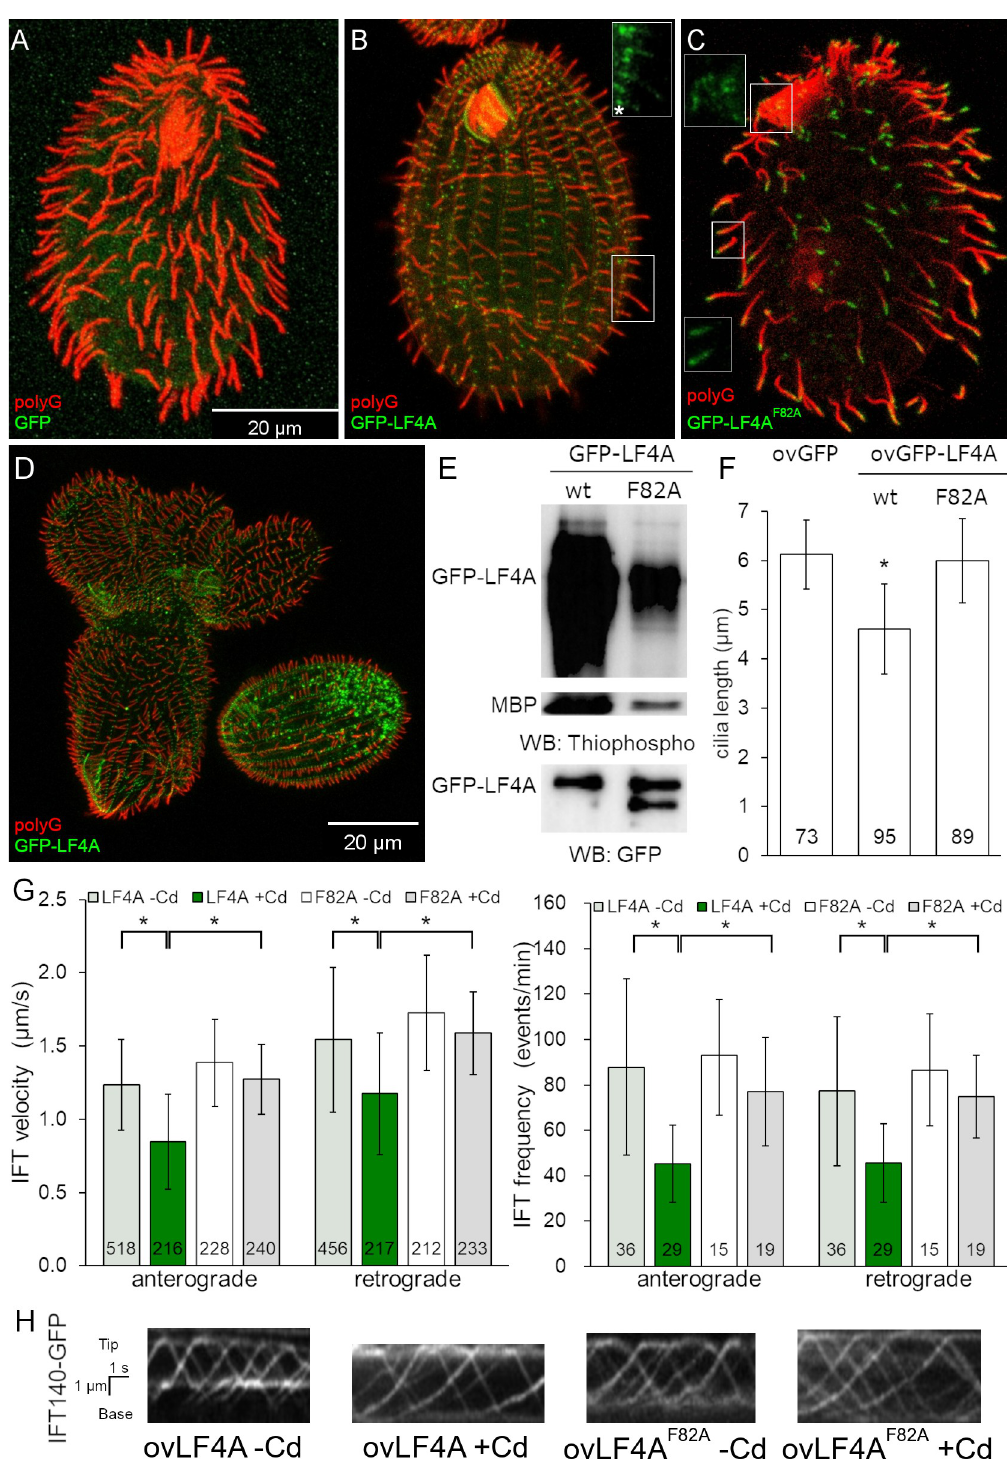
Fig 3. Excessive LF4A kinase activity shortens cilia and decreases IFT. (A-C) Cells (treated with 2.5 μ g/ml CdCl 2 for 6 hours) overexpressing either GFP (A), GFP-LF4A (B) or GFP-LF4A F82A (C) showing GFP fluorescence (green) and labeled by the anti-polyG tubulin antibodies to visualize cilia (red). The shortening of cilia is evident only in the cell expressing GFP-LF4A (B) where it is enriched at the basal bodies (asterisk). GFP-LF4A F82A accumulates at the tips of cilia (C). The insets in B-C show the green signal of GFP-LF4A alone at higher magnification. (D) GFP-LF4A-overexpressing cells after overnight